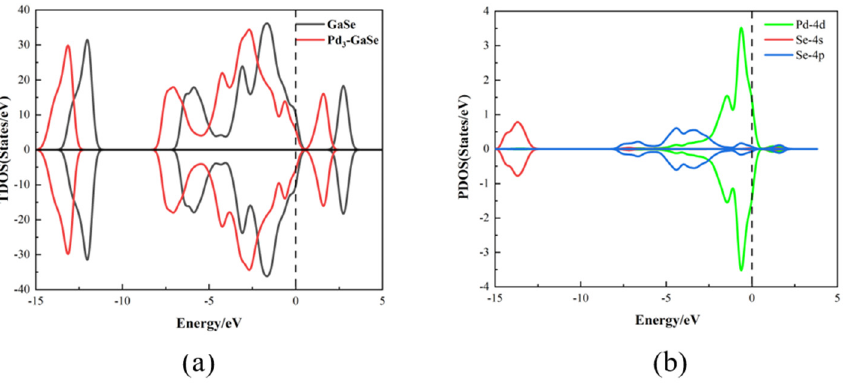
Figure 6. ( a ) TDOS of GaSe monolayer, Pd 3 -GaSe monolayer, ( b ) PDOS of Pd 3 -GaSe monolayer.